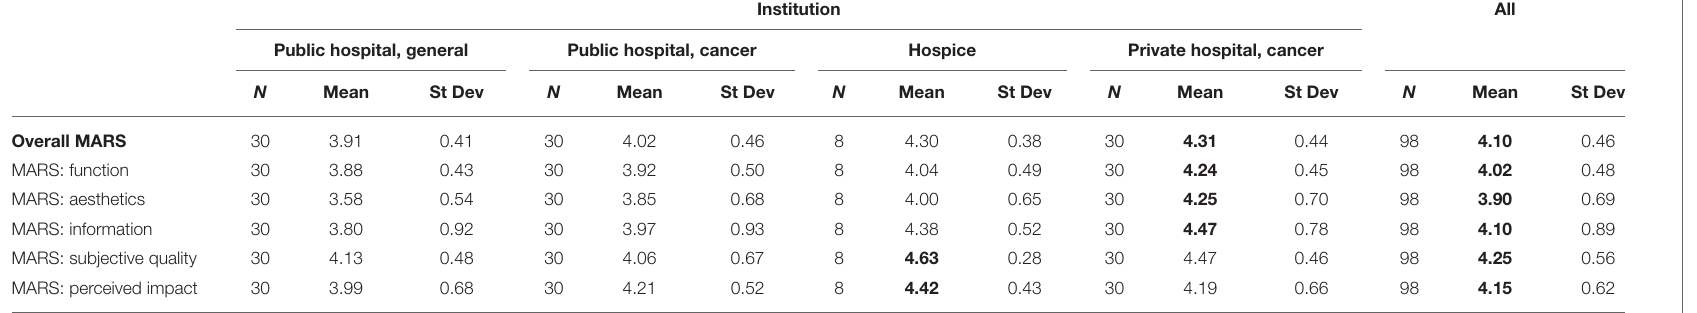
TABLE 7 | Summary of MARS scores, by subcategories.